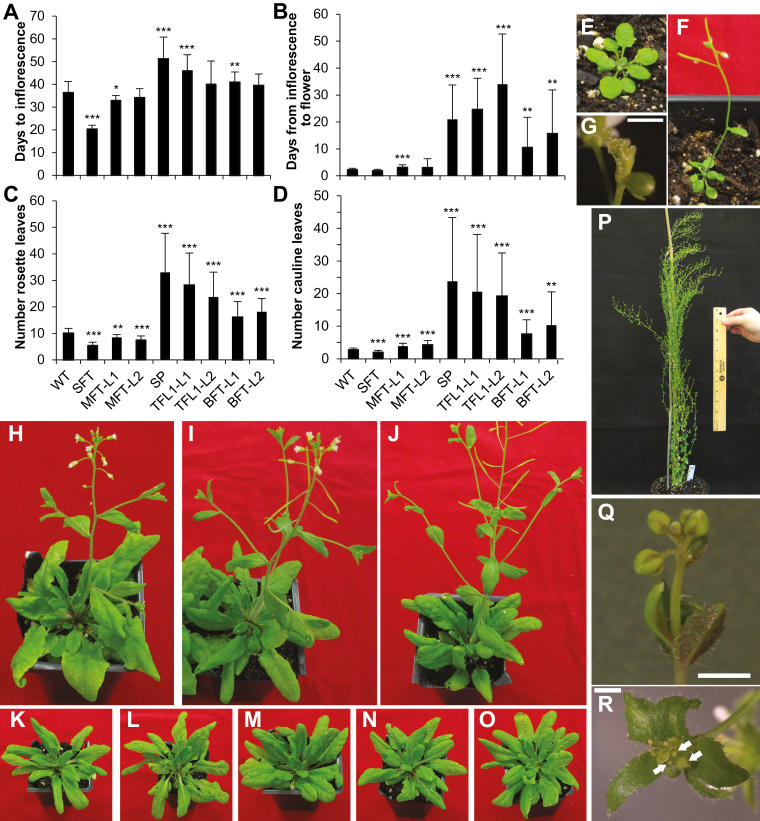
Ectopic expression of GhCETS genes differentially impacts on phase changes in Arabidopsis. The effects of 35Spro::GhCETS upon the transition to reproductive growth were quantified using (A) the days to inflorescence, when the inflorescence measured 1 cm in height, (B) the days from inflorescence to flowering, when white petals were visible, (C) the number of rosette leaves present at flowering, and (D) the number of cauline leaves present by anthesis. Data are means (±SD) (n=18). Means from each 35Spro::GhCETS treatment were compared to untransformed wild-type Col-0 (WT) using Student’s t-test: *P<0.05, **P<0.01,***P<0.001. (E) WT at 3 weeks post-germination produces a small rosette, but (F) 35Spro::GhSFT lines are flowering at 3 weeks and (G) some produce homeotic terminal flowers (five out of 18 lines). (H) At 7 weeks post-germination WT plants are flowering, as are (I) 35Spro::GhMFT-L1 and (J) 35Spro::GhMFT-L2 lines. At 7 weeks, the transition to reproductive growth is delayed among (K) 35Spro::GhSP, (L) 35Spro::GhTFL1-L1, (M) 35Spro::GhTFL1-L2, (N) 35Spro::GhBFT-L1, and (O) 35Spro::GhBFT-L2 lines. Ectopic expression of genes of the TFL1-like clade produced the I1* phase. In (P), the 35Spro::GhSP line remains in the I1* phase at 16 weeks post-germination. (Q) A cluster of flowers surrounded by whorled, leaf-like organs is observed in 35Spro::GhTFL1-L1 lines in the I1* phase. (R) A floral structure from the 35Spro::GhTFL1-L2 line in the I1* phase, with multiple floral buds (arrows) initiating within the innermost whorl. Scale bars are 1 mm.